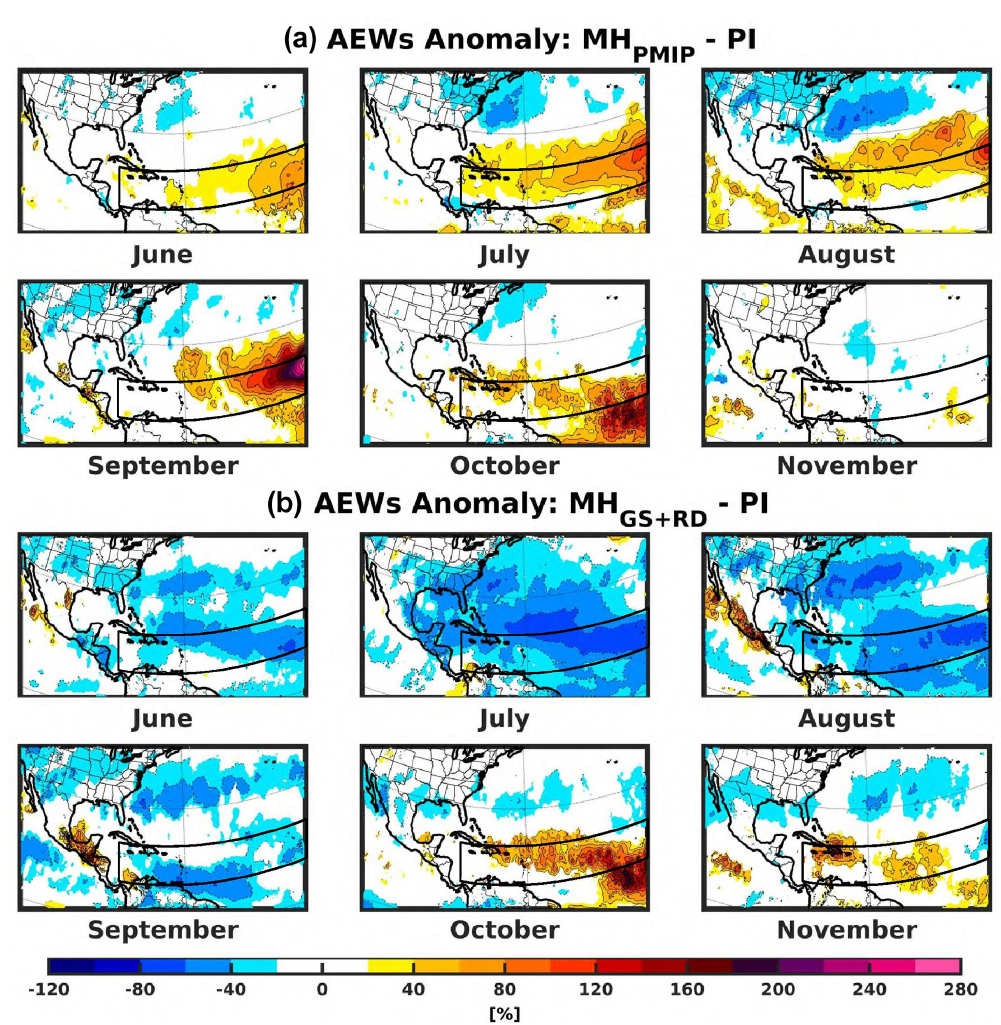
Figure 7. Monthly AEW anomalies represented through the variance of the meridional wind at 700hPa, filtered in the 2.5 to 5d band, for (a) MH PMIP and (b) MH GS + RD relative to PI. The black box shows the approximate present-day MDR. Only values that are significantly different at the 5% level using a local (grid-point) t test are shaded. The contour lines follow the color-bar scale (dashed, negative anomalies; solid, positive anomalies); the 0 line is omitted for clarity.